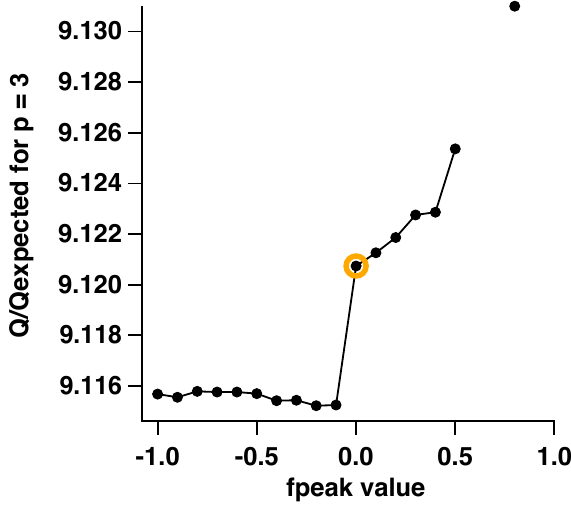
Fig. A2. Q/Q exp for varying fpeak values for p = 3. The circled marker is the presented solution.